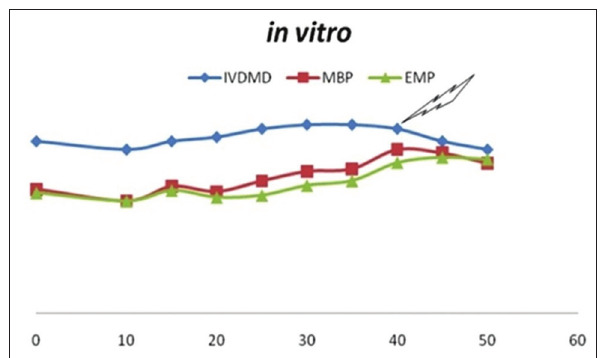
Figure-1: In vitro dry matter degradability, microbial biomass production, efficiency of microbial biomass